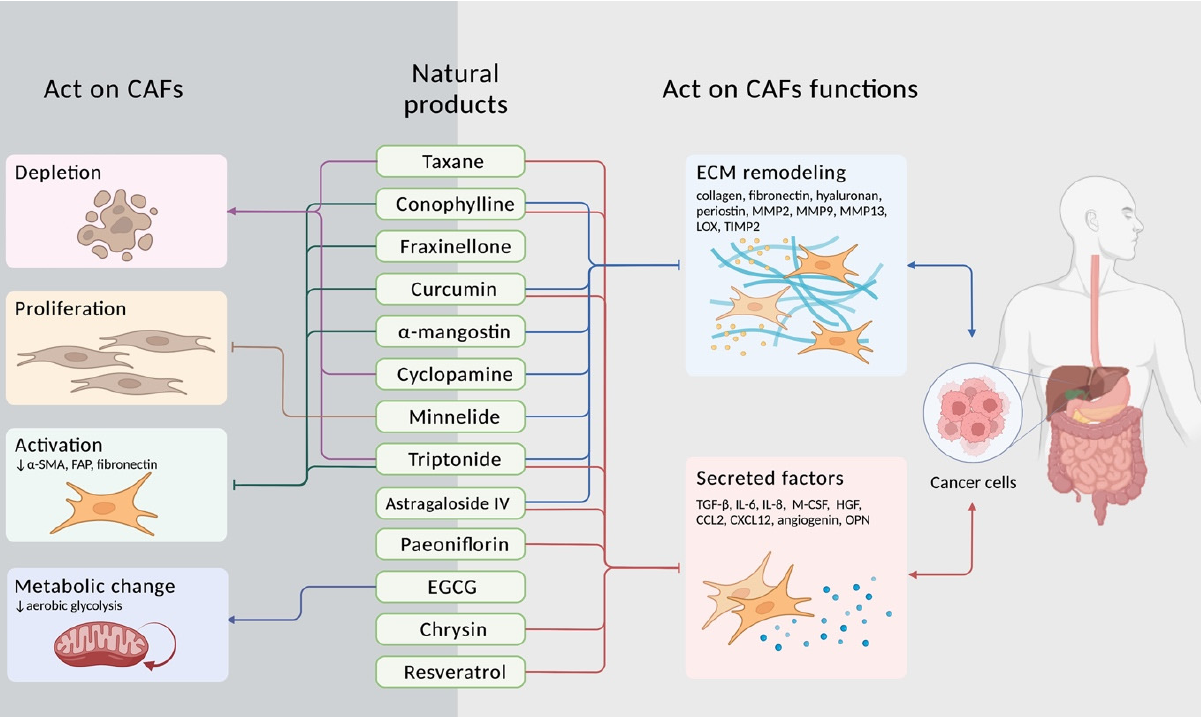
Figure 3. Natural products targeting CAFs to treat digestive system cancer. Several natural products might have therapeutic advantages to digestive system cancer progression by targeting CAFs. Most of the listed natural products have been regarded as health-beneficial compounds. Some of them have been utilized as chemotherapy such as taxane; others have been considered as traditional Chinese medicines (TCM) for a long time, such as triptolide and astragaloside IV; others are combined with chemotherapy as adjuvant therapy, like conophylline, curcumin, cyclopamine, and resveratrol. The antitumor functions of these natural products can be divided into two main aspects: (1) Some natural products act on CAFs depletion, proliferation, activation, or changing CAFs’ metabolism. (2) Some products target CAFs’ functions of ECM remodeling and paracrine secretion. The symbol ( ↓ in the figure) is representative of the downregulation effect due to the treatment of natural